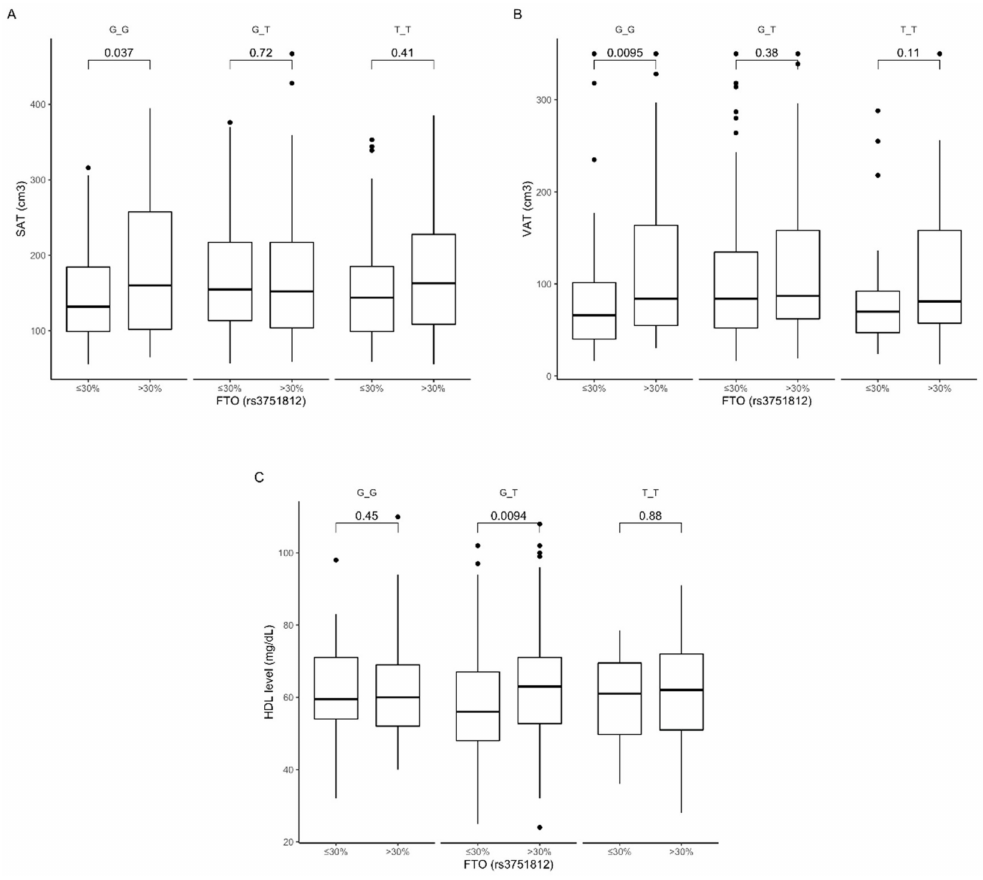
Figure 4. Association of dietary fat intake ≤ 30% and > 30% of total daily energy intake with ( A ) SAT (cm 3 ), ( B ) VAT (cm 3 ), and ( C ) HDL level (mg / dL) in FTO rs3751812 genotype